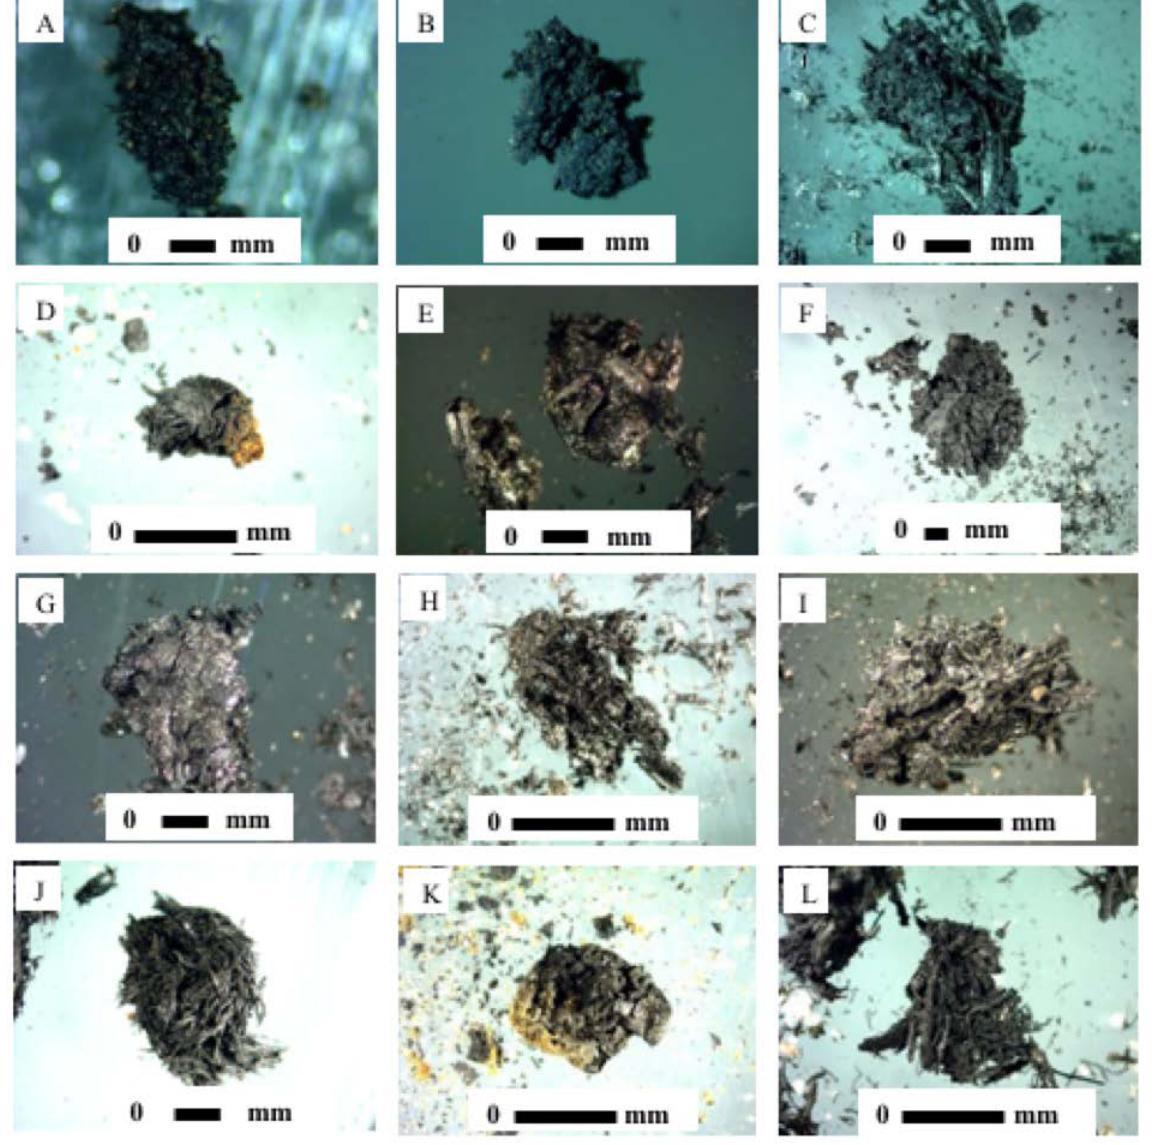
Figure 3. Charred peat identification Plate. Charred peat aggregates created in the laboratory from the global peatland samples obtained from the Geography Department at the University of Exeter. A: All Saints Bog; B: Sebangau Swamp; C: Manacrin Moor; D: Walton Moss; E: Crater Pool; F: Electric Bog; G: Fallahogy Bog; H: Fagelmossen; I: Dosenmoor; J: Instrument Bog; K: North Uist; L: Railway